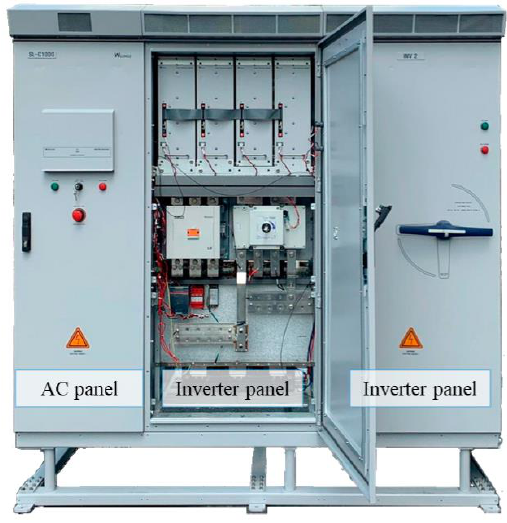
Figure 10. Image of the 1 MW PV inverter system. Table 5. Specification of the 1 MW PV inverter system.